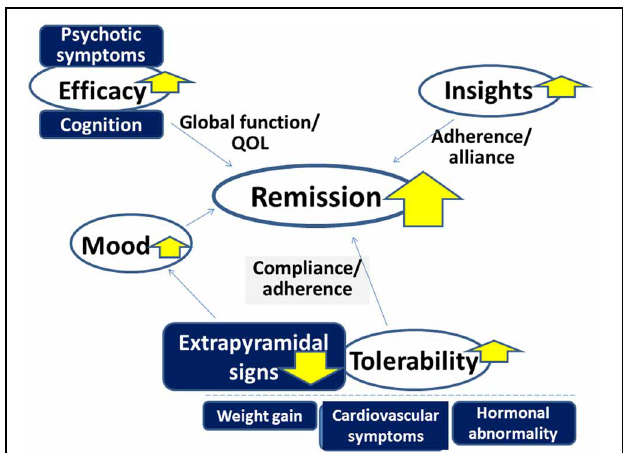
improving outcome in the treatment of psychotic disorders. Compared to typical antipsychotic drugs, AAPDs elicit fewer incidences of extrapyramidal signs, which enhance compliance and adherence. AAPDs may also demonstrate greater efficacy for mood symptoms. The superiority of AAPDs in terms of ameliorating psychotic symptoms and cognitive impairment is under debate. The development of newer antipsychotic drugs with minimal adverse events associated with some existing AAPDs, e.g., weight gain, cardiovascular symptoms, and hormonal abnormalities, may provide an effective strategy to attain greater remission